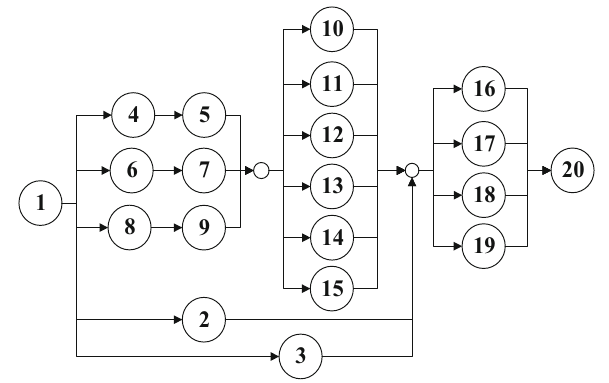
Fig. 7 General AON network for single carrier-based aircraft operations belong to the set of candidate maintenance oper- ations in F g ), is initialized. Next, operation ( i , j ) is selected from set D g , advanced with a step size of 1 from t bd ; fur- thermore, the start and end times of ( i , j ) are specified. If the resource occupation status satisfies the demand of ( i , j ), and assign maintenance personnel and equipment/workshop to ( i , j ); Finally, ( i , j ) is added to F g , and the scheduling schedule is expanded continuously to complete the schedul- ing assignment of the entire maintenance task. The procedure for CR is shown in Fig. 6.